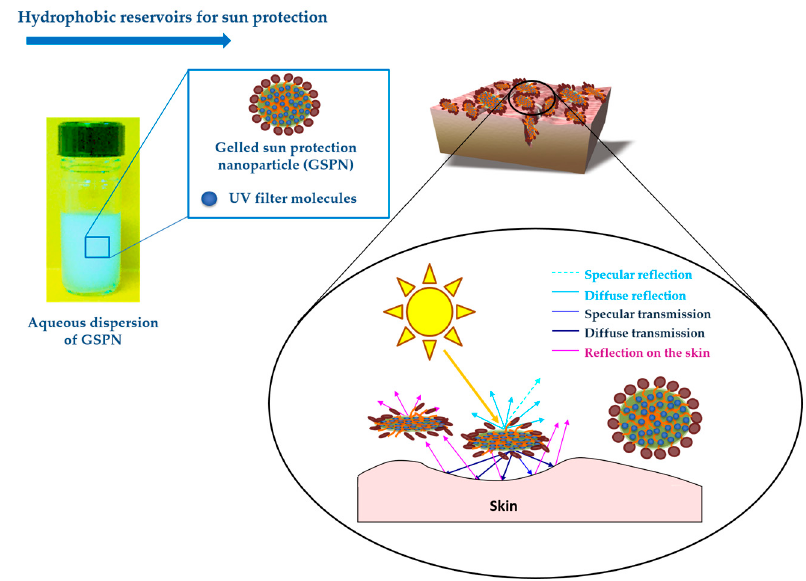
Figure 10. Representation of gelled sun protection nanoparticles (GSPN) and their photoprotection ability mechanism.